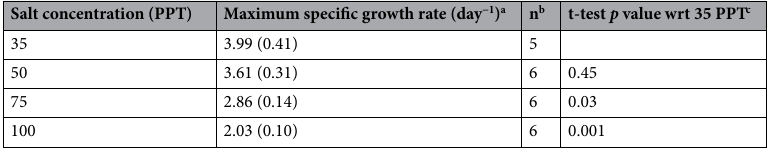
Table 3. Maximum specific growth rates of Picochlorum celeri at 25 °C as a function of marine salt concentration and grown in DISCOVR medium. a Standard error is given in the brackets. b n represents the number of replicates for each condition. c Gives the t-test p value for each concentration with respect to growth rates at 35